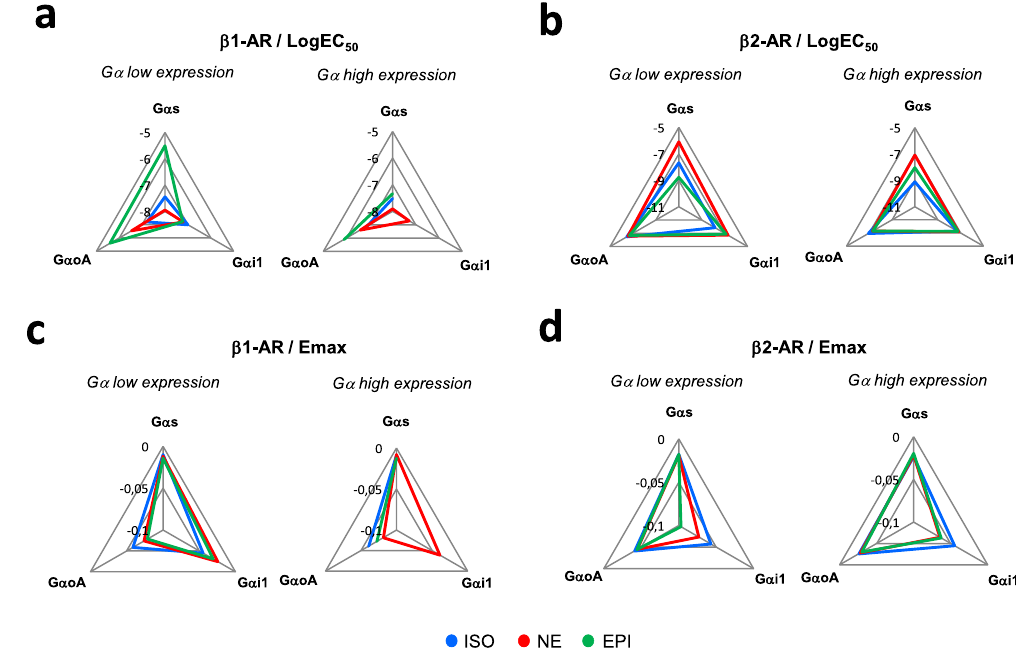
Figure 4. Schematic multi-axial profiling of β -AR agonist efficacies and potencies at G protein activation with different G α expression levels. ( a – d ) ISO, NE or EPI potencies ( a , b ) or maximal efficacies ( c , d ) at G protein (G α s, G α i1, G α oA) activation upon stimulation of β 1-AR ( a , c ) or β 2-AR ( b , d ) presented in Fig. 3 and Supplementary Tables 2 and 3 are shown in a